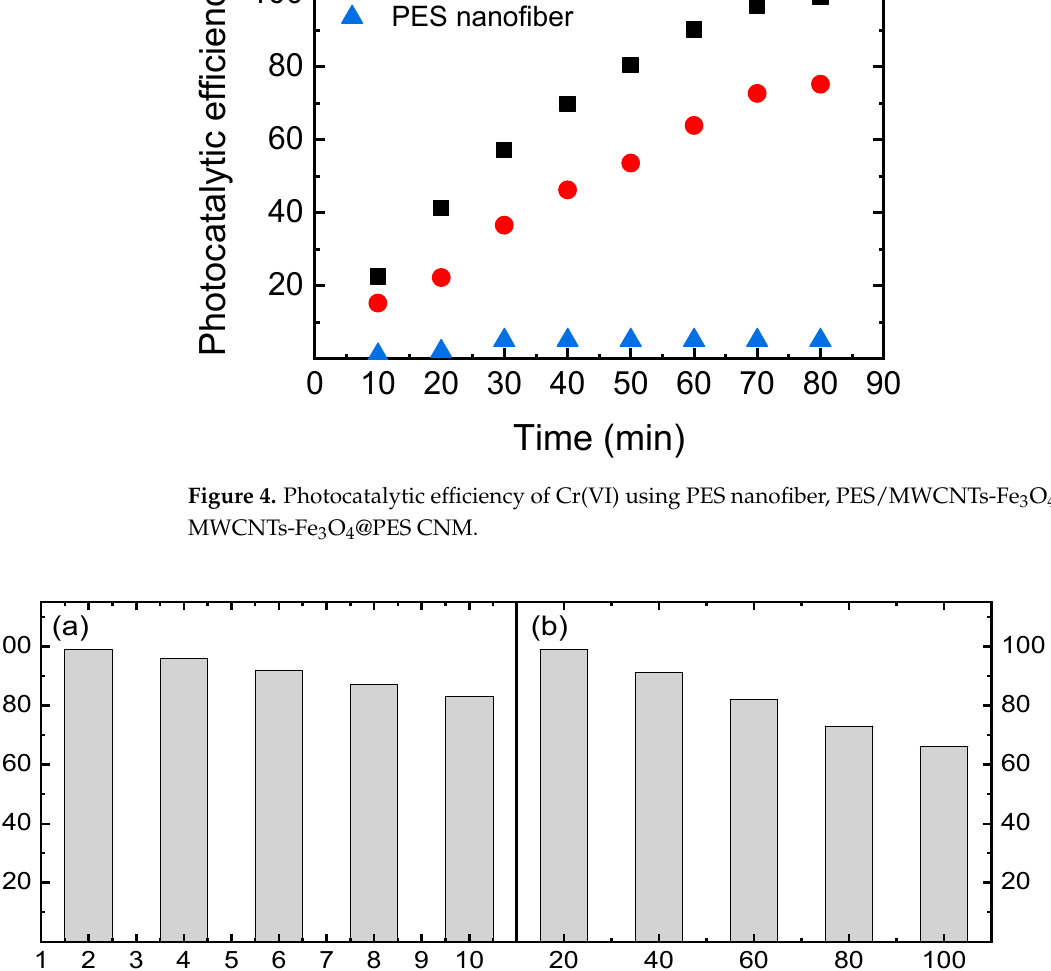
Cr(VI) Concentration (mg/L) Figure 5. The effect of ( a ) pH and ( b ) concentration on the photocatalytic efficiency of Cr(VI) using the MWCNTs-Fe 3 O 4 @PES CNM.